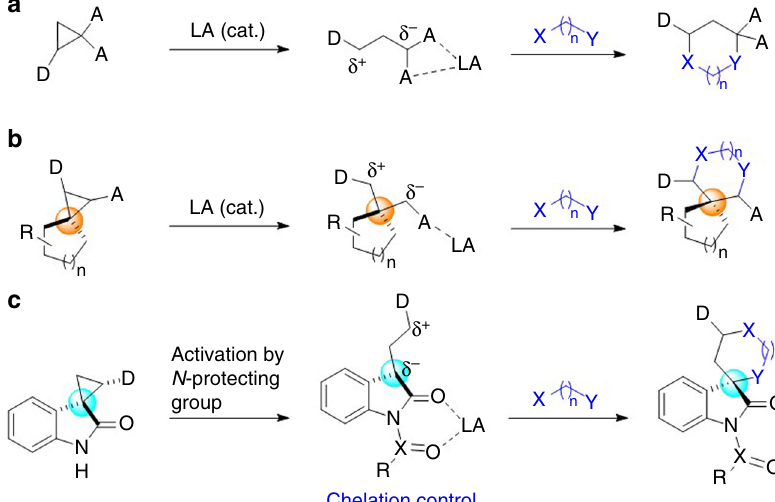
Fig. 1 Enantioselective cycloaddition reactions using D − A cyclopropanes. a Well-established cyclic compounds synthesis. b Undeveloped spiro stereocenter generation compounds synthesis. c Activation of spirocyclopropyl oxindoles for cycloaddition reactions. Donor (D): electron-releasing group; Acceptor (A): electron-withdrawing group (CO 2 R or